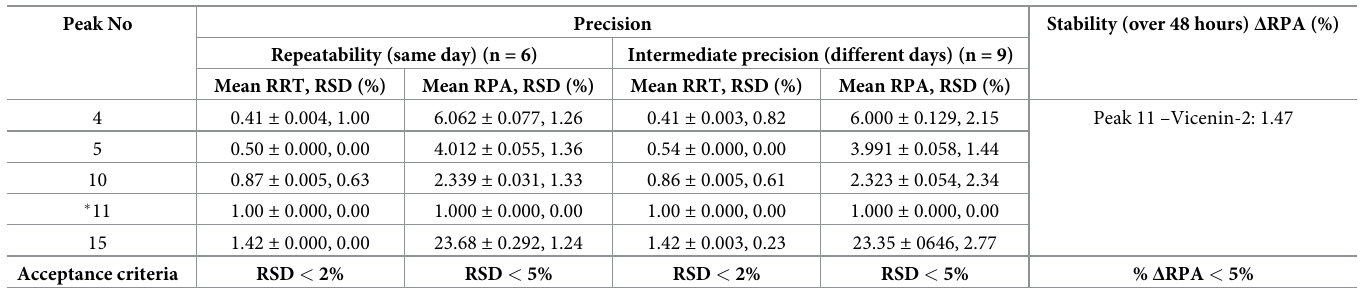
Table 5. Validation parameters for UPLC Fingerprint profiling of ESB